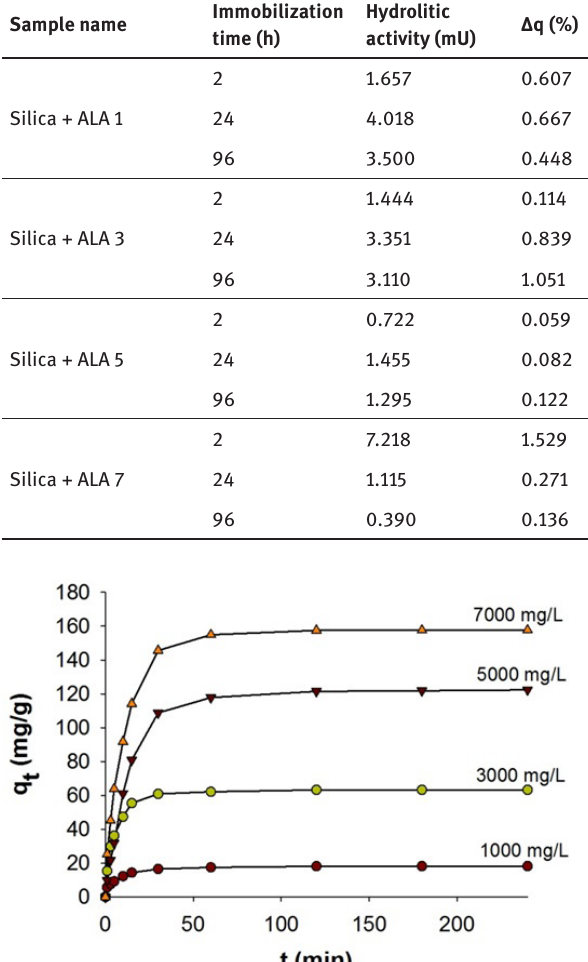
Figure 7: Effect of contact time on the amount of enzyme adsorbed on the Stöber silica (enzyme concentration 1000 – 7000 mg L -1 , support use 0.5